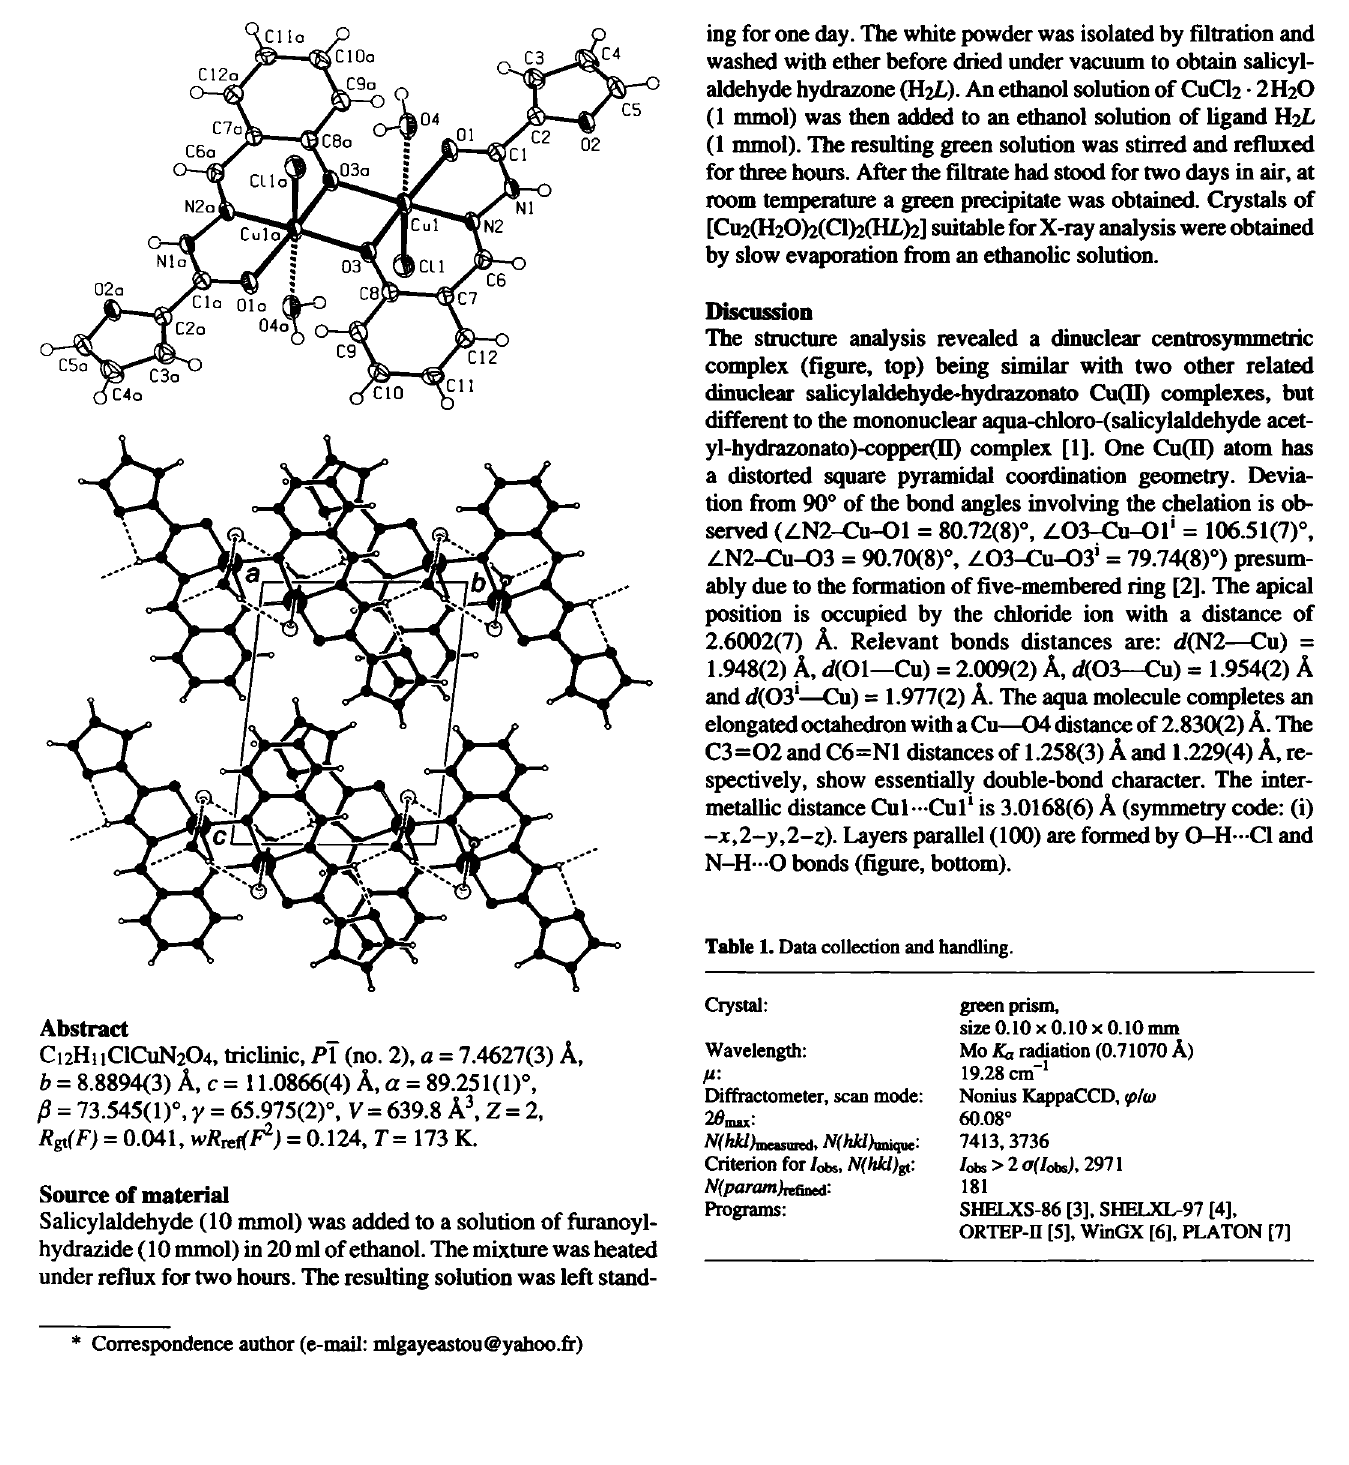
Table 1. Data collection and